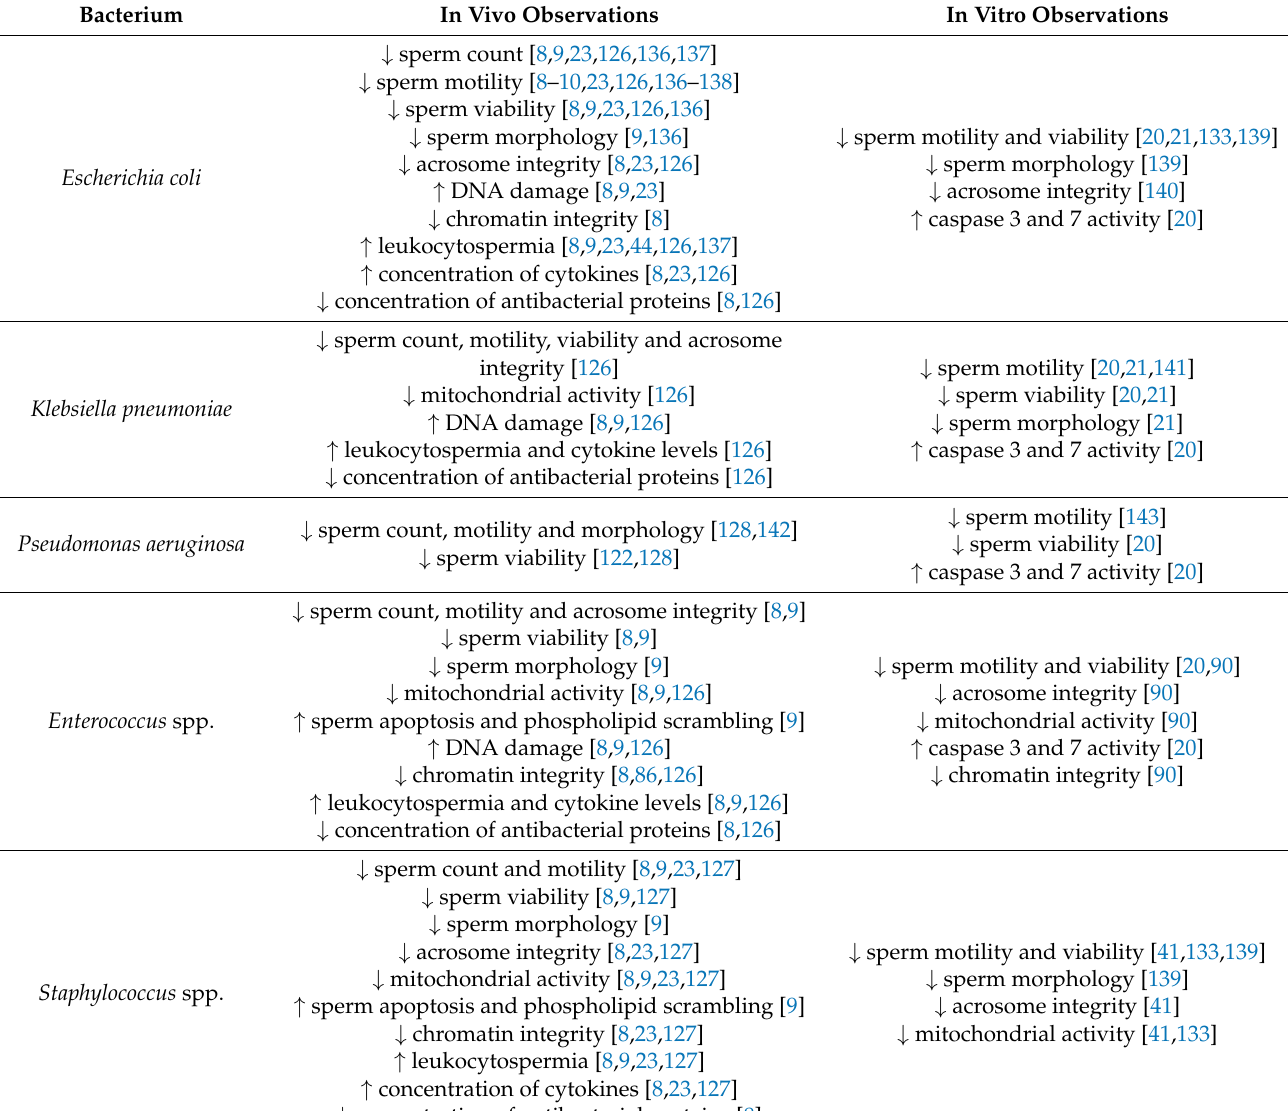
Table 1. Leading consensual in vivo and in vitro effects of the most frequent uropathogenic bacteria on semen quality and/or sperm structural integrity and functional